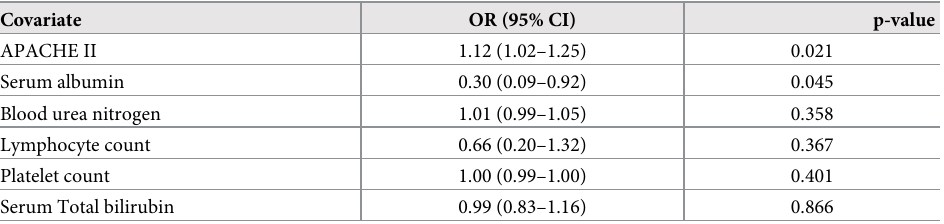
Table 4. Multivariate analysis of risk factors for mortality, F . nucleatum and F . varium